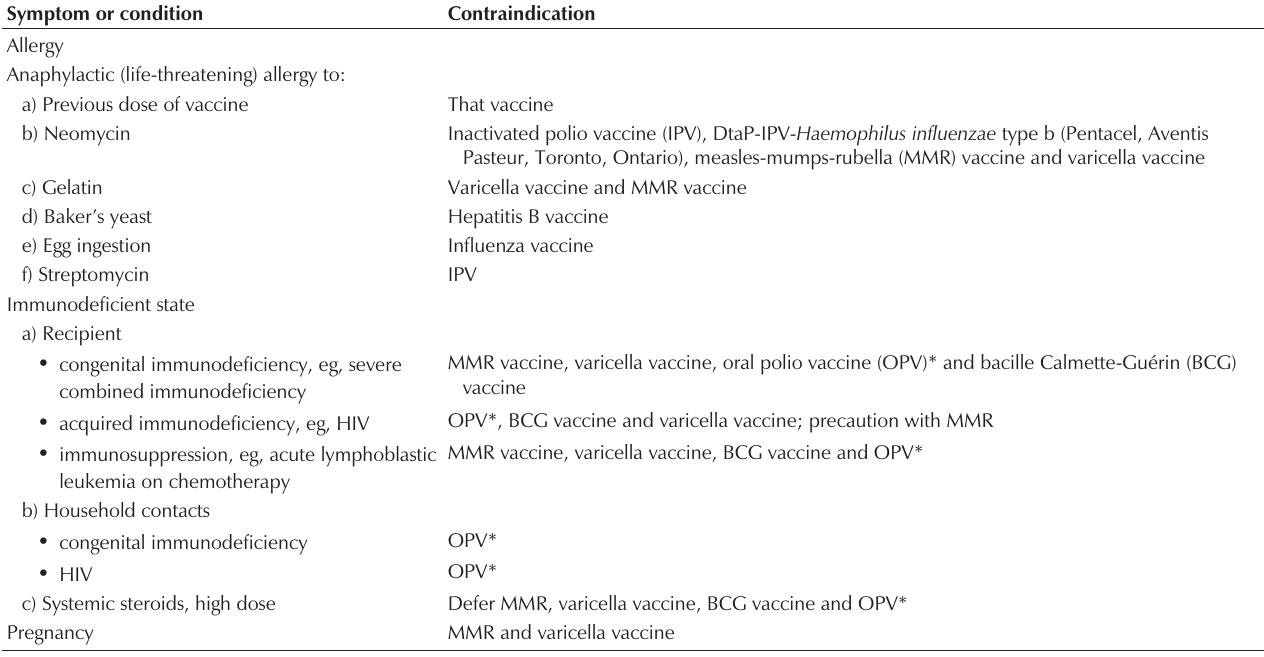
TABLE 1: Contraindications to childhood vaccinations as recommended by the National Advisory Committee on